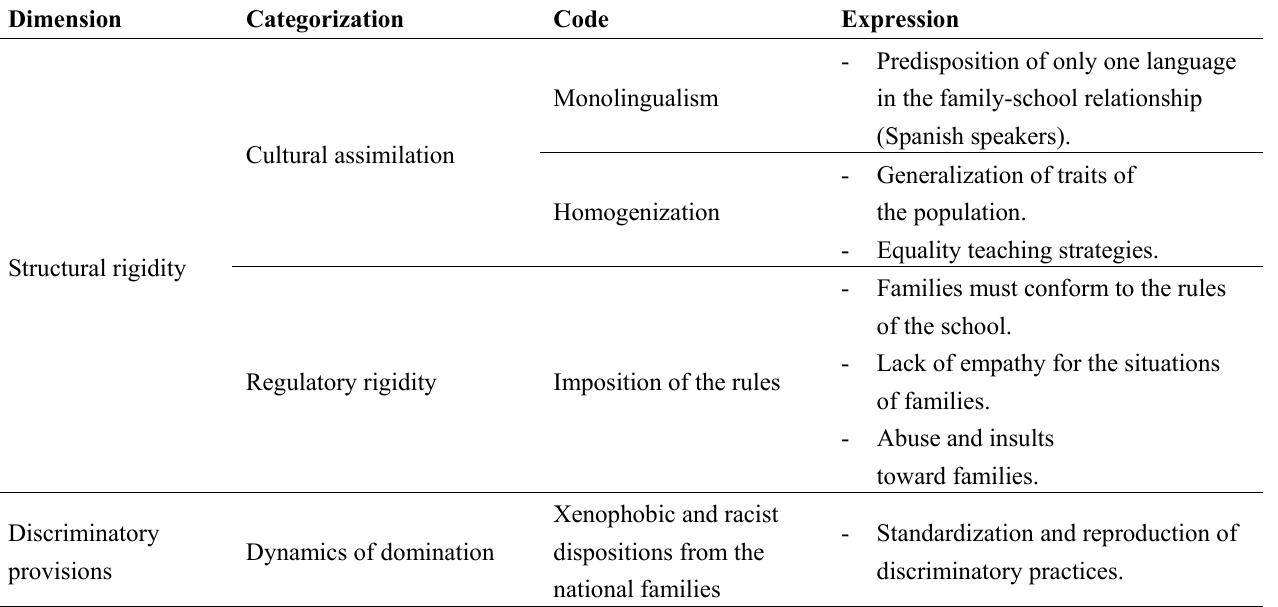
Table 6. Structuralization of symbolic